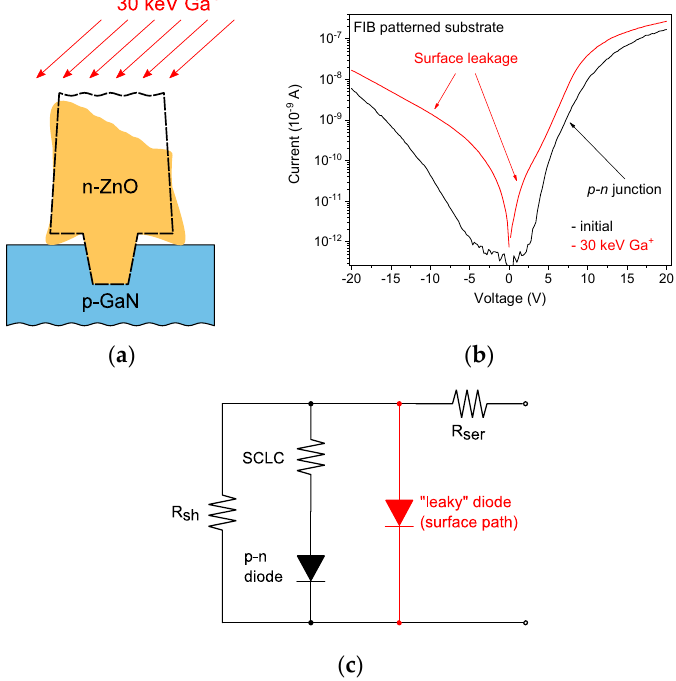
Figure 8. ( a ) Schematic of the cross-section of the of ZnO / GaN interface on FIB-patterned GaN substrates GaN with a restored conductive path after post-growth FIB milling. ( b ) Semi-logarithmic I – V plots for the single nanorod ZnO / GaN heterojunction on FIB-patterned GaN substrates before and after restoring the surface conductive path. ( c ) The electrical circuit of a single nanorod heterojunction with the additional surface leakage path.